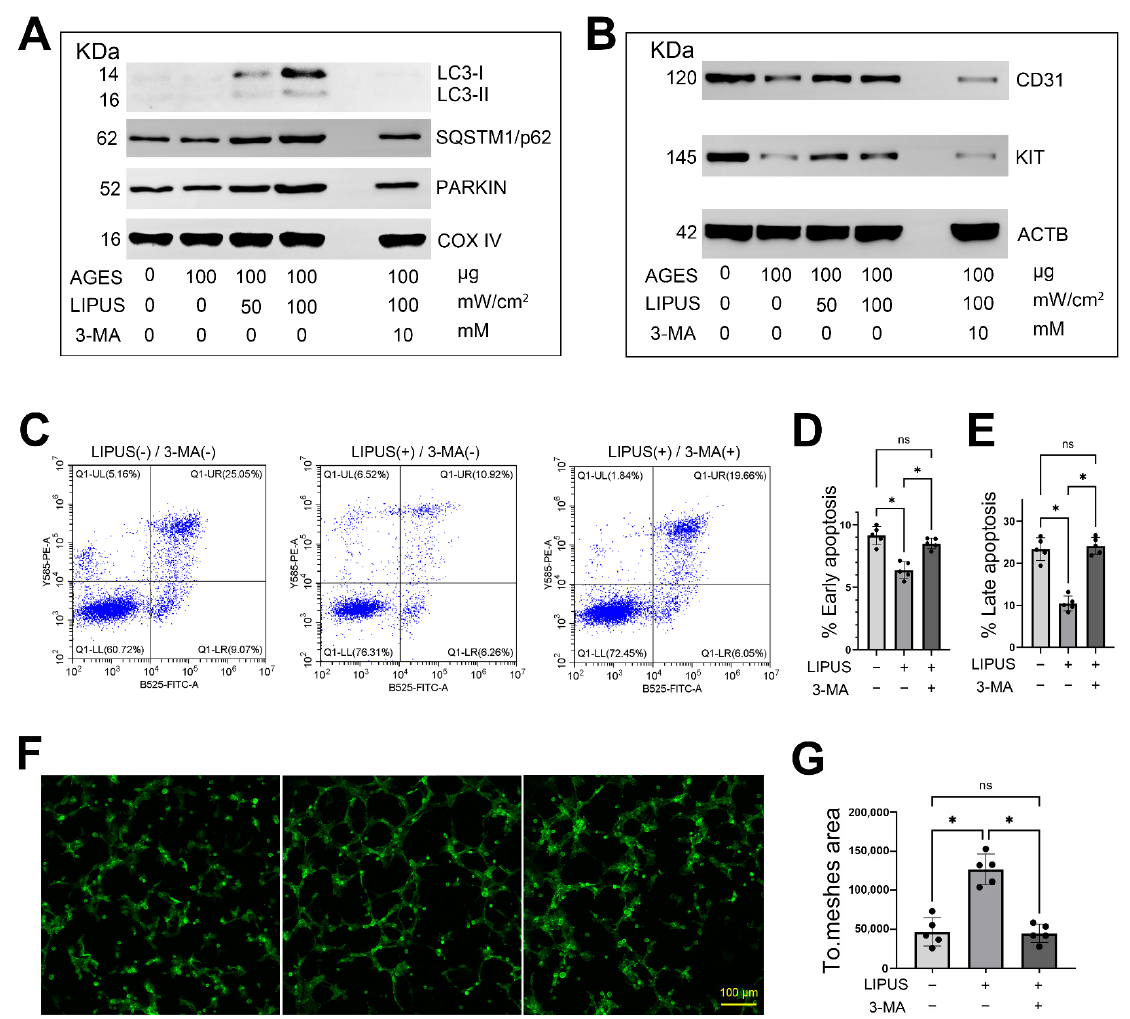
Figure 8. Inhibition of mitophagy attenuates the therapeutic effect of LIPUS. ( A ) Western blotting shows the expression change of mitophagy related proteins (LC3, p62 and PARKIN) in CCECs treated with AGES, LIPUS, and/or 3-MA. The expression levels of COX IV were used as a loading reference for total mitochondrial protein. The Western blotting result based on 2 independent repeats with a similar trend. ( B ) Western blotting shows the expression change of corpus cavernosum endothelial markers (CD31 and KIT) in CCECs treated with AGES, LIPUS, and/or 3-MA. The expression levels of ACTB were used as a loading reference for total cell protein. The Western blotting result based on 2 independent repeats with a similar trend. ( C – E ) Flow cytometry demonstrates the 3-MA treatment on the early apoptosis ( B ) and late apoptosis ( C ) of CCECs after LIPUS treatment. The existence of Annexin V ( X -axis) and the nuclear staining of PI ( Y -axis) by flow cytometry are shown. n = 5 independent repeats. Data are shown as mean ± SD. ns, not significant; *, p < 0.05. ( F , G ) Phalloidin staining shows typical changes of CCECs tube formation after 3-MA and/or LIPUS treat- ment. The total mesh area score is used to represent the level of tube formation in each group. n = 5 independent repeats. Data are shown as mean ± SD. ns, not significant; *, p < 0.05. AGES: advanced glycation end products; LIPUS: low-intensity pulsed ultrasound; 3-MA: 3-methyladenine.